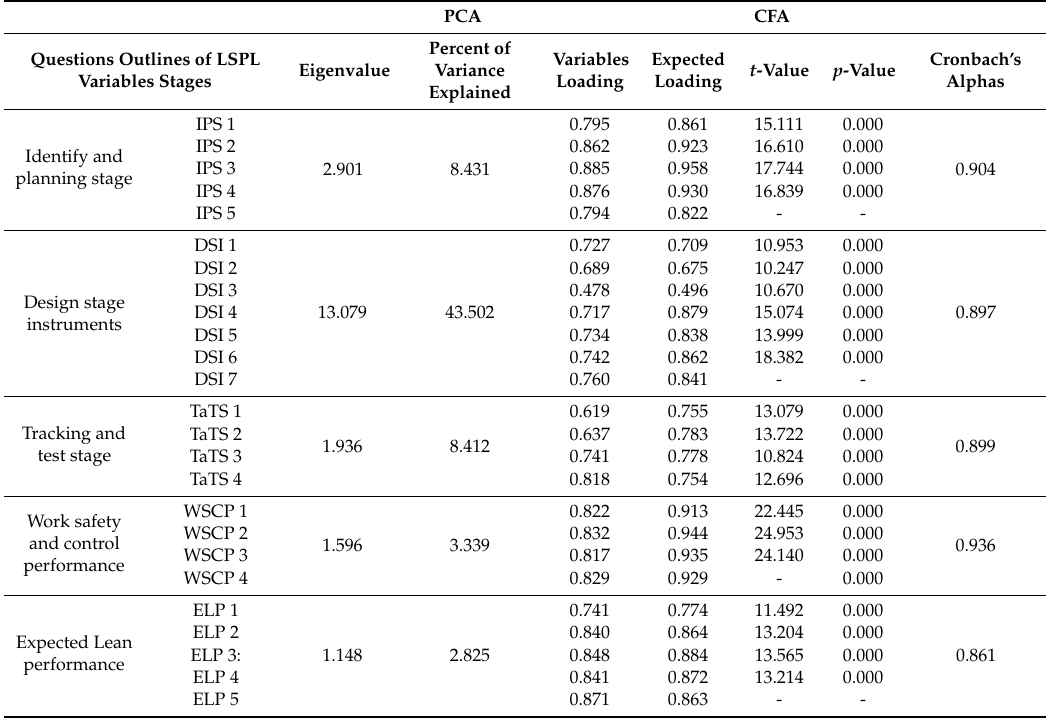
Table 13. Results of principal component analysis (PCA) and confirmatory factor analysis (CFA) for LSPL framework validations.